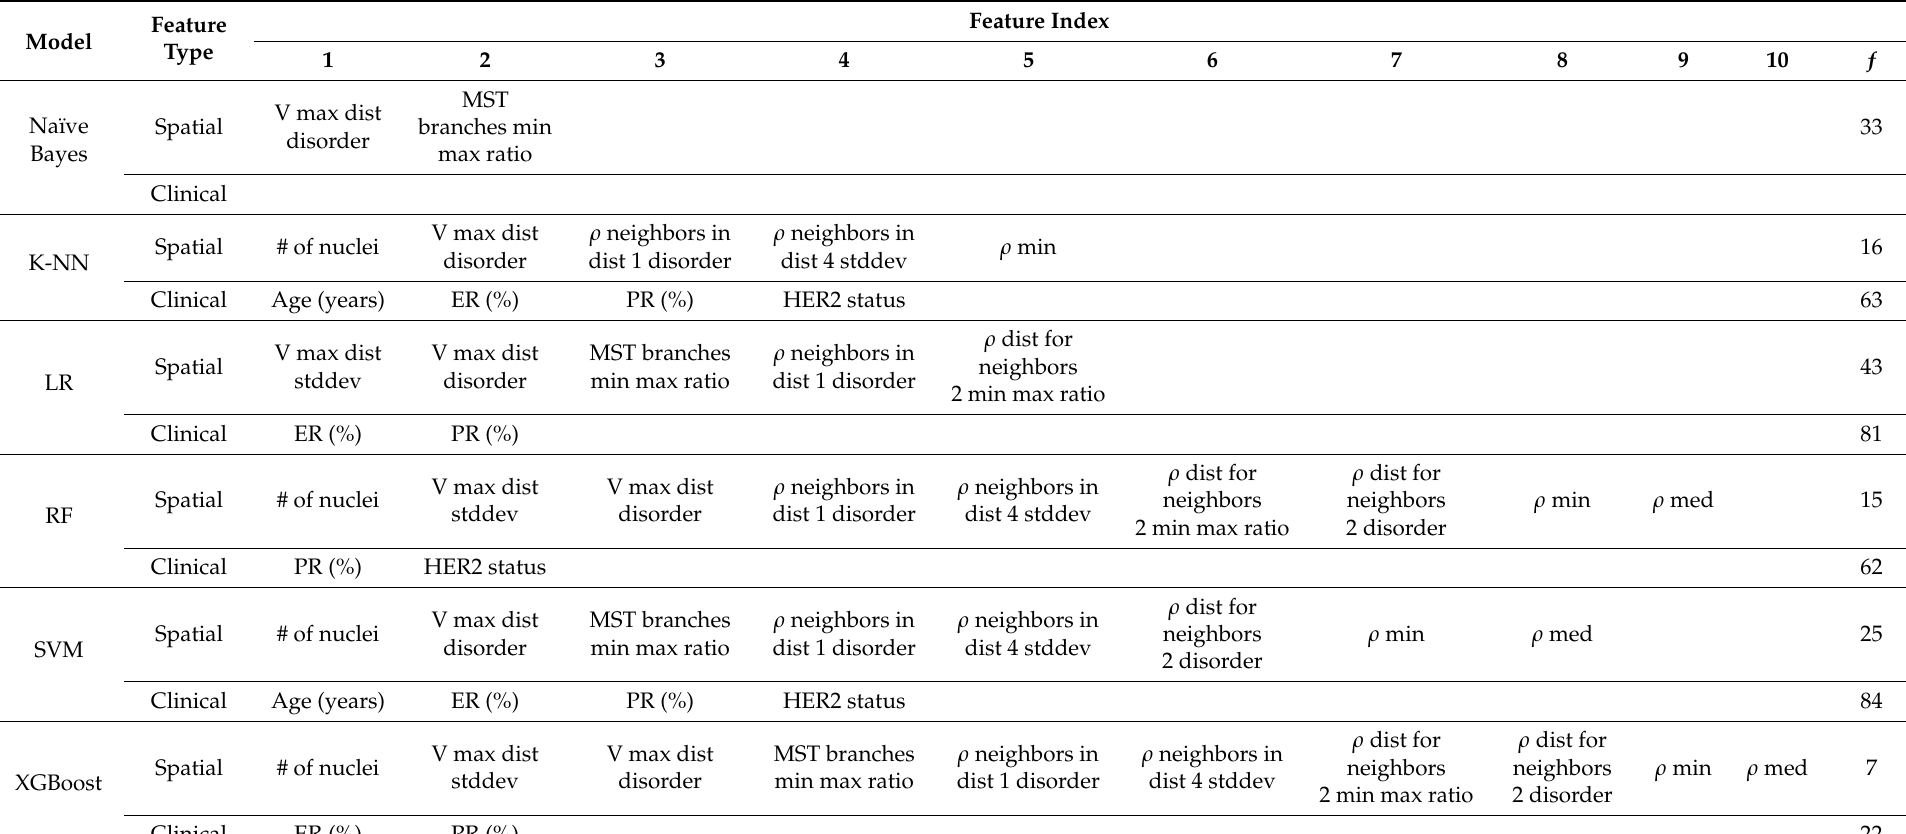
Table 2. Most frequently occurring spatial and clinical feature sets. One hundred iterations of sequential forward feature selection were performed per model. The most frequently occurring clinical and spatial feature sets are reported. Abbreviations: K-NN, K-nearest neighbor; LR, logistic regression; RF, random forest classifier; SVM, support vector